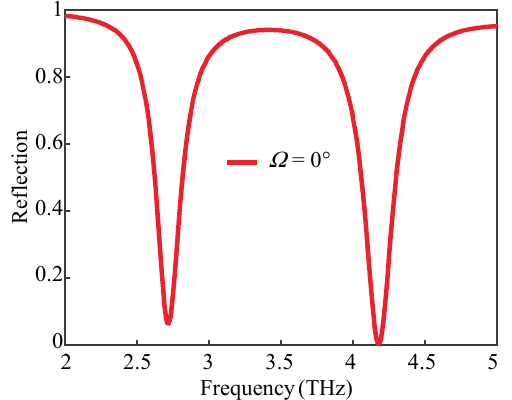
Fig. 3 Reflection S 112 in a terahertz range of 2 THz – 5 THz. The angle of incidence Ω of EM plane wave is